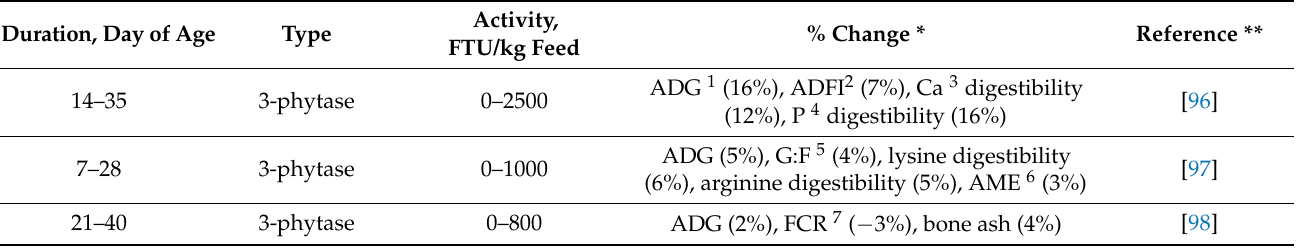
Table 1. A list of studies since 2000 describing effects of 3- and 6-phytase supplemented individually at different levels in diets for broiler